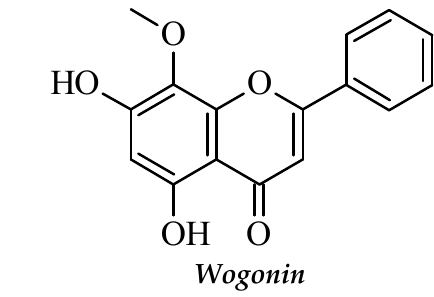
Figure 15. The structures of baicalein and wogonin.